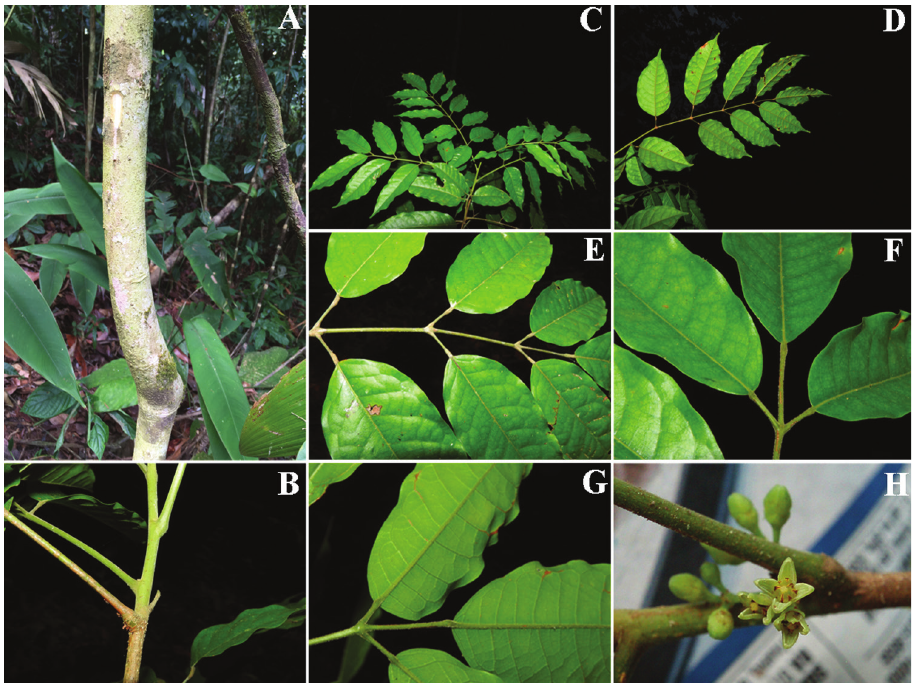
Figure 2. Protium aguilarii . A Trunk and bark B Twigs C Branch with leaves D Leaves showing abaxial side of leaflets E Leaf showing adaxial side F Leaflet bases G Venation H Flower. Photo credits: Reinaldo Aguilar ( A–G ) from D. Santamaría et al. 9851 ; and Xavier Cornejo ( H ) from R. Aguilar & X. Cornejo